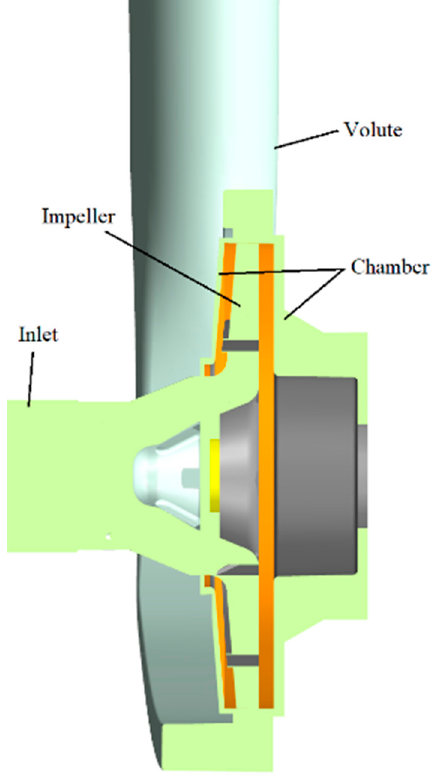
Figure 3. Model of computational domains.